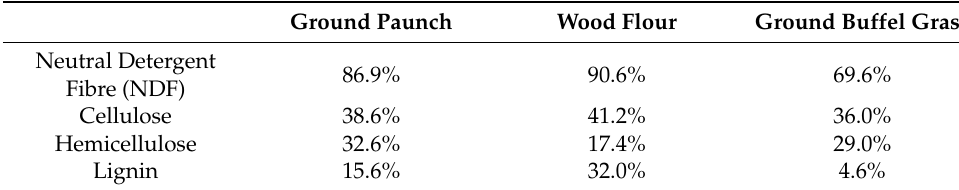
Table 1. Cellulose, hemicellulose and lignin contents of ground paunch, wood flour and ground buffel grass.